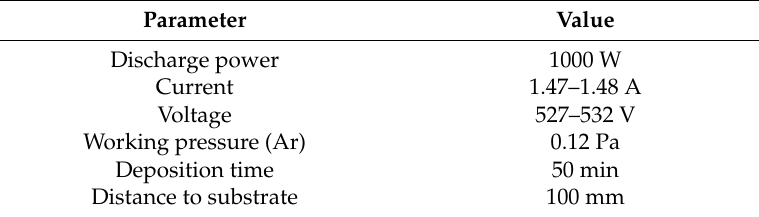
Table 1. Deposition